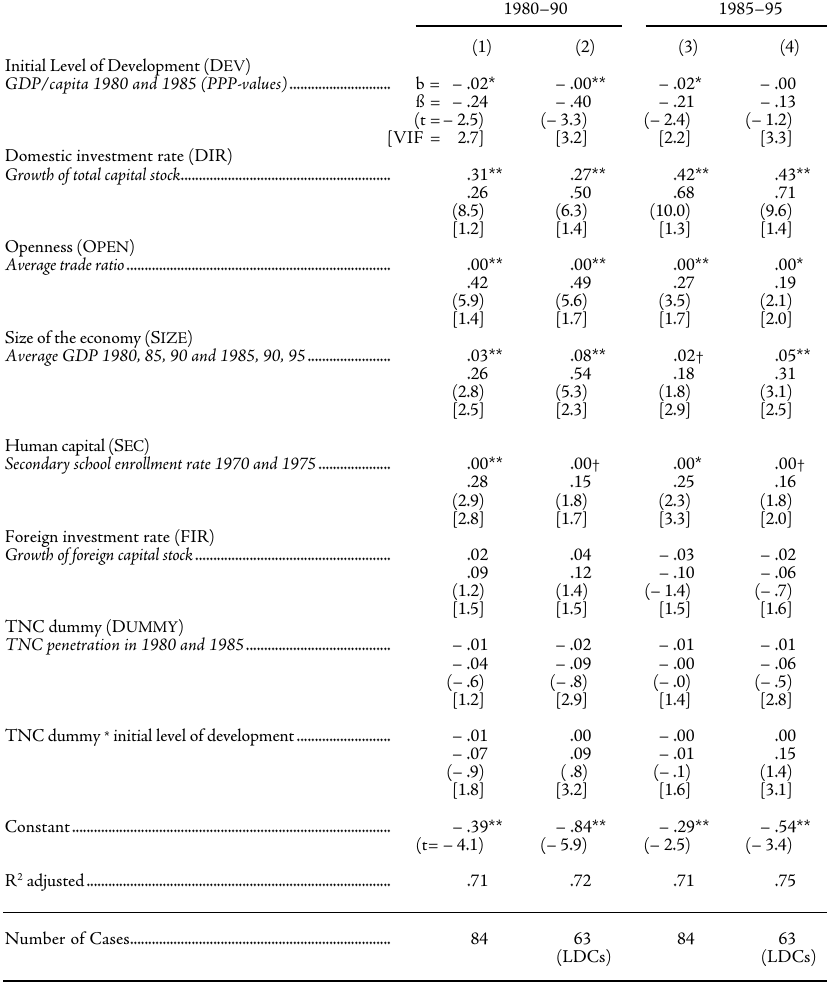
Table 3 – Dependent Variable: GDP per capita growth; OLS